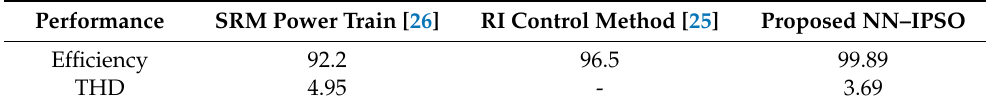
Figure 7. Performance analysis of efficiency. PLECS does not quite expose the thermal losses connected to the electrical domain, because the switching losses are introduced as energy impulses in zero-time. Instead, it employs the most recent junction temperature information to compute fresh thermal losses. As a result, when employing the thermal domain, the only valid computation for efficiency is to subtract the thermal losses from the power supply to predict an imbalance between a primarily electrically calculated efficiency and a recognized technique that in- cludes ohmic losses in the switch components (on-resistances), and to attempt to evaluate the energy while including all electrical losses due to resistances in the passive elements. Figure 8 shows the efficiency value of the proposed NN – IPSO. Figure 9 shows the zoom view of the efficiency graph. An on-board PHEV battery pack depending on an isolated converter architecture is suggested in this paper. To improve the charger ’ s switching effi- cacy, the best performance for the converter design is used.